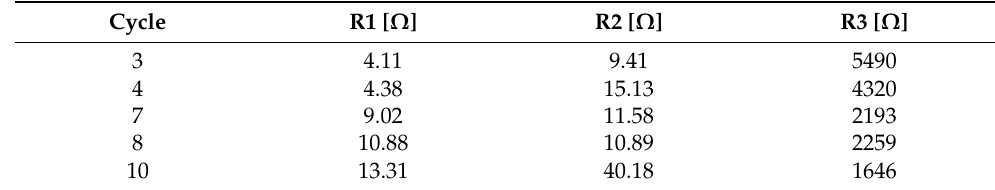
Table 1. R1, R2 and R3 values upon cycling.